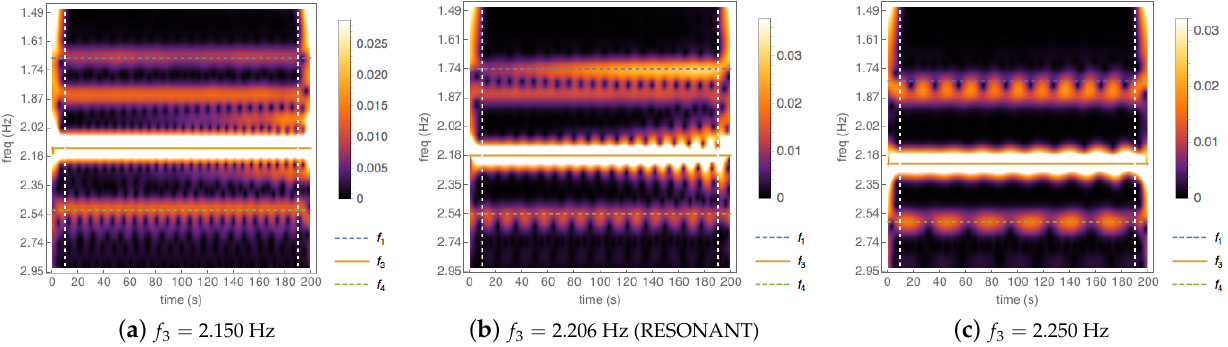
Figure 5. Scaleograms for the plane-wave numerical probe data with t = 200 s, produced by sampling 10,000 time points and performing a wavelet transform using Gabor wavelets with 48 oscillations, with a scale resolution of 11 frequency scales along with 64 voices per scale. Vertical lines represent the initial and final times t = 10 s, 190 s for the calculation of the efficiency to the target mode f 1 that avoids spurious boundary effects. Horizontal lines represent the theoretical (cid:112) g | k | /2 π for the wavevectors K 1 = K 3 − K 2 , K 3 frequencies f 1 , f 3 and f 4 stemming from the dispersion relation f ( k ) = and K 4 = K 3 + K 2 . The width about the frequencies f 1 and f 4 is of the order ∆ f = 0.05 f